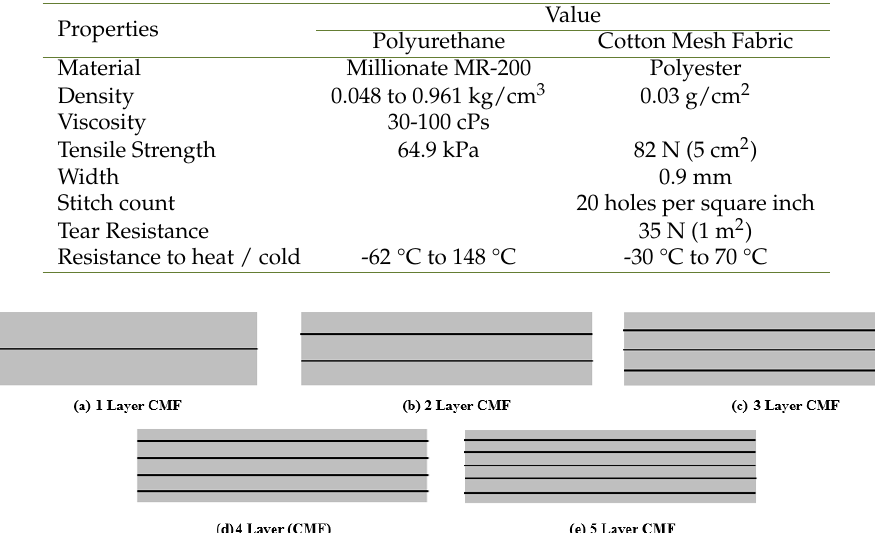
Fig. 1. Polyester CMF Layer Number Scheme (a) 1 Layer, (b) 2 Layer, (c) 3 Layer, (d) 4 Layer, and (e) 5 Layer